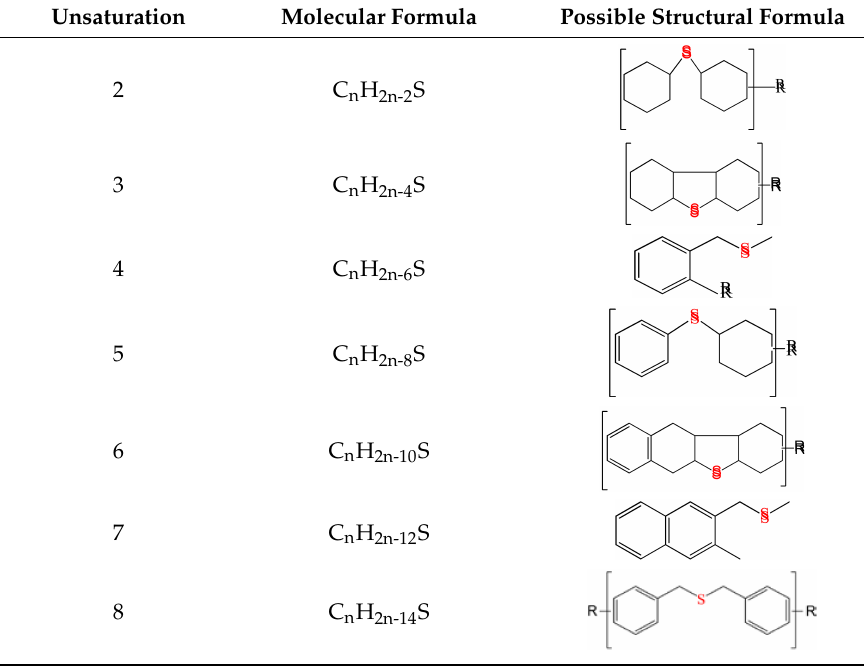
Table 4. Test results of thioether sulfurin transformer